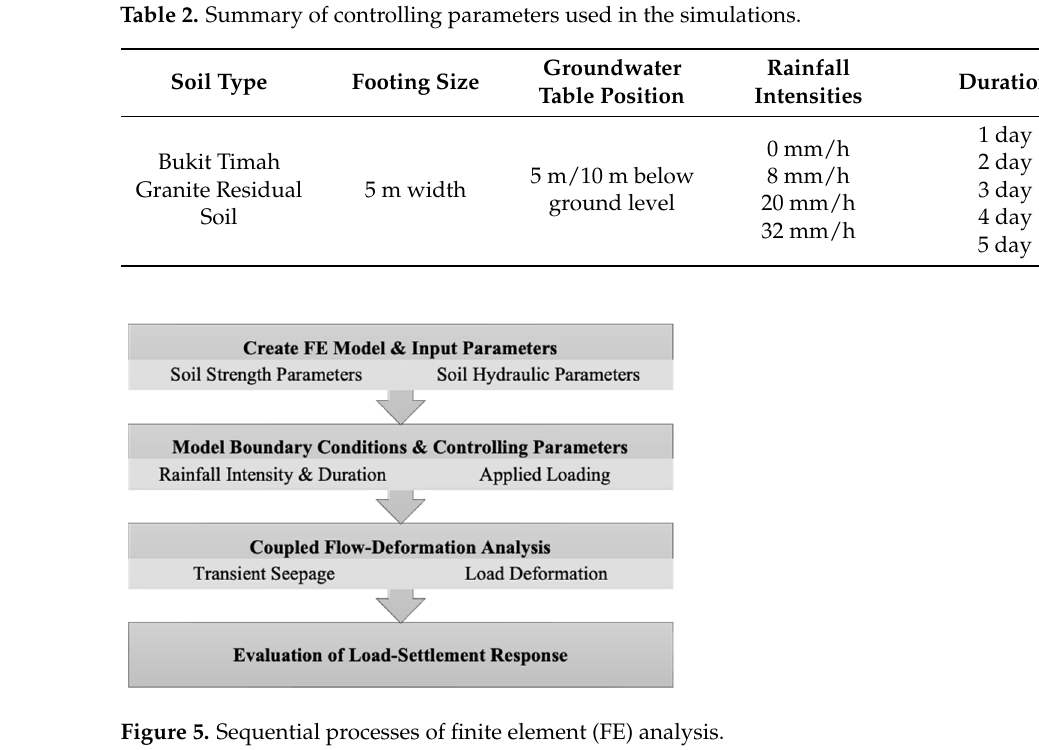
Figure 4. Unsaturated permeability function for BTG residual soil [32].